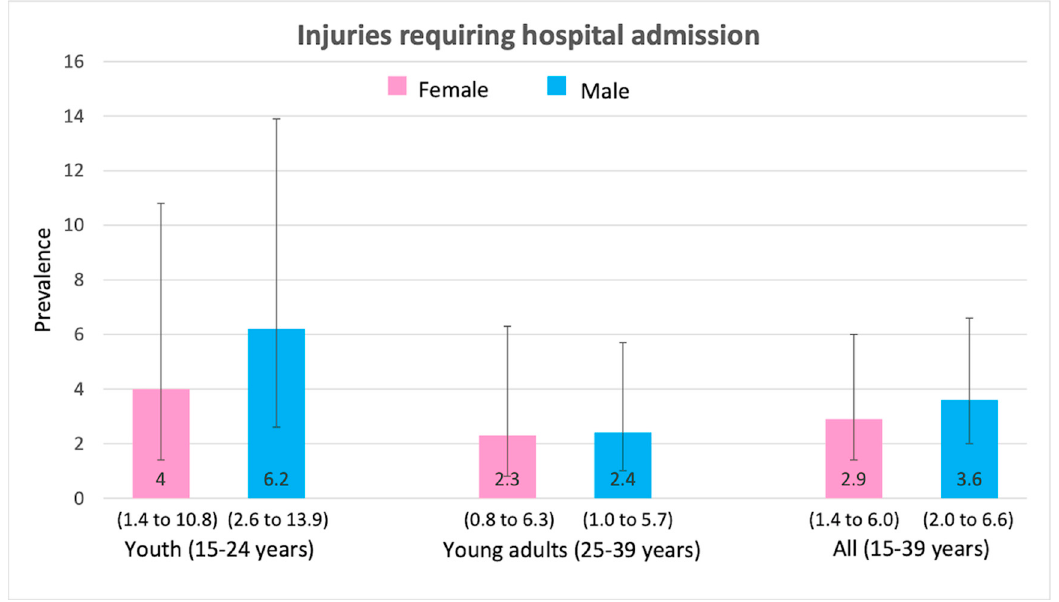
Figure 2. Prevalence (and 95% CI intervals) of injuries requiring hospital admission by age group and gender.